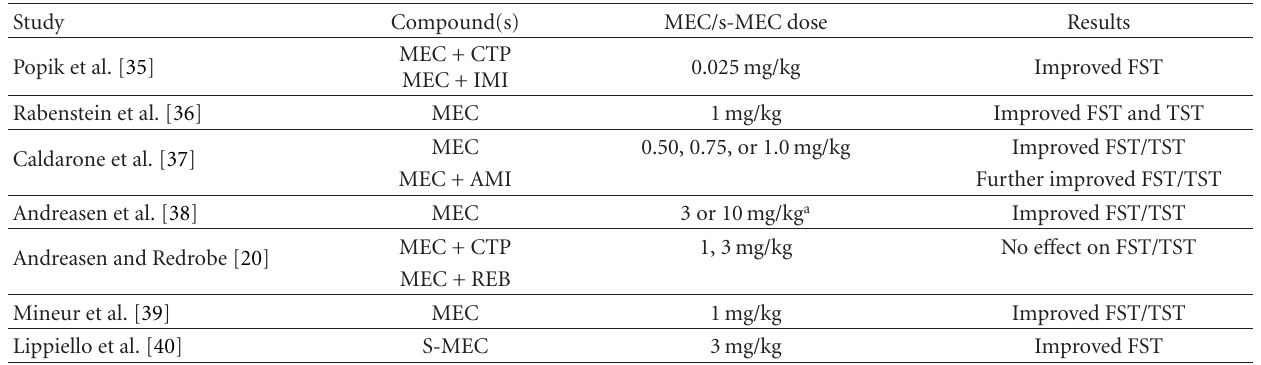
Table 1: Evidence for MEC/S-MEC in mouse models of